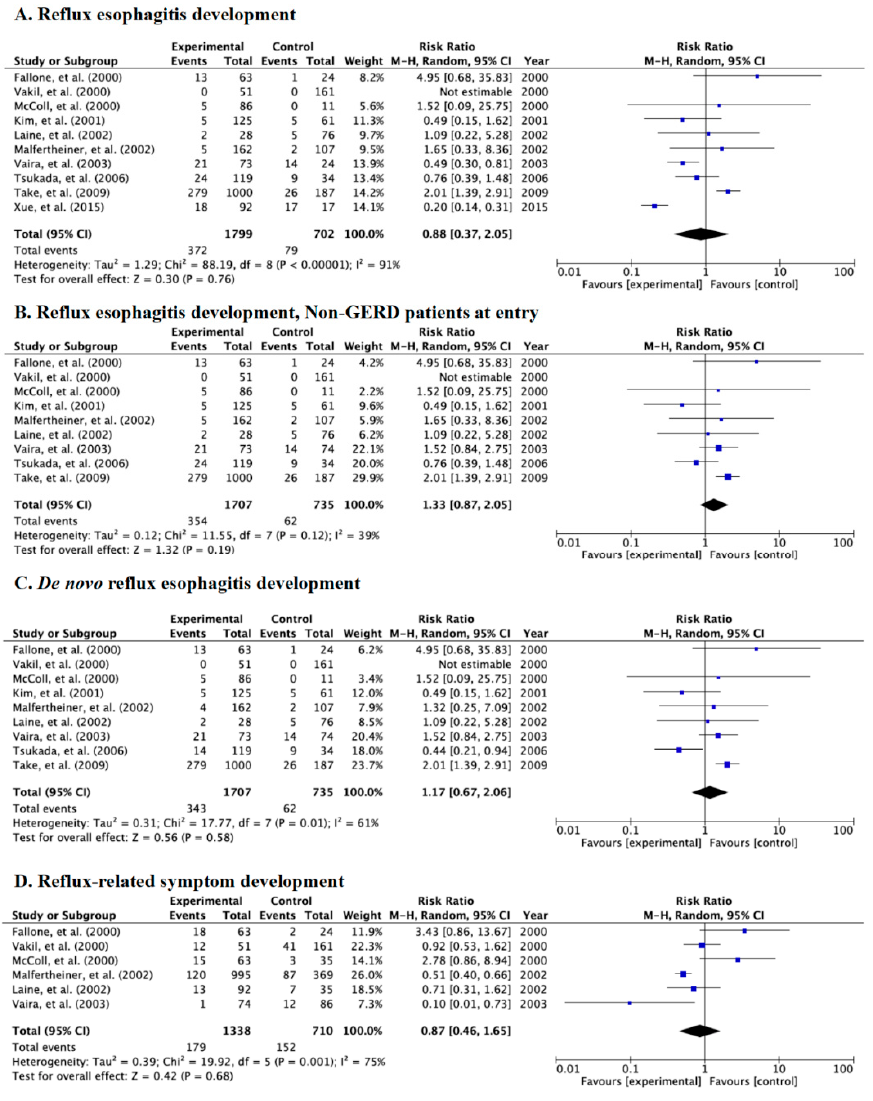
Figure 4. Forest plots of the rate of patients with reflux esophagitis development after eradication irrespective of whether they were free from gastroesophageal reflux disease (GERD) at baseline ( A ), reflux esophagitis after eradication in patients free from GERD at baseline ( B ), the rate of de novo reflux esophagitis newly developed after eradication ( C ), and the rate of patients with reflux-related symptoms after eradication therapy ( D ) in the random-e ff ects model in Category B. No significant di ff erence in reflux esophagitis and symptoms was shown between the case and control groups. Abbreviations: CI, confidence